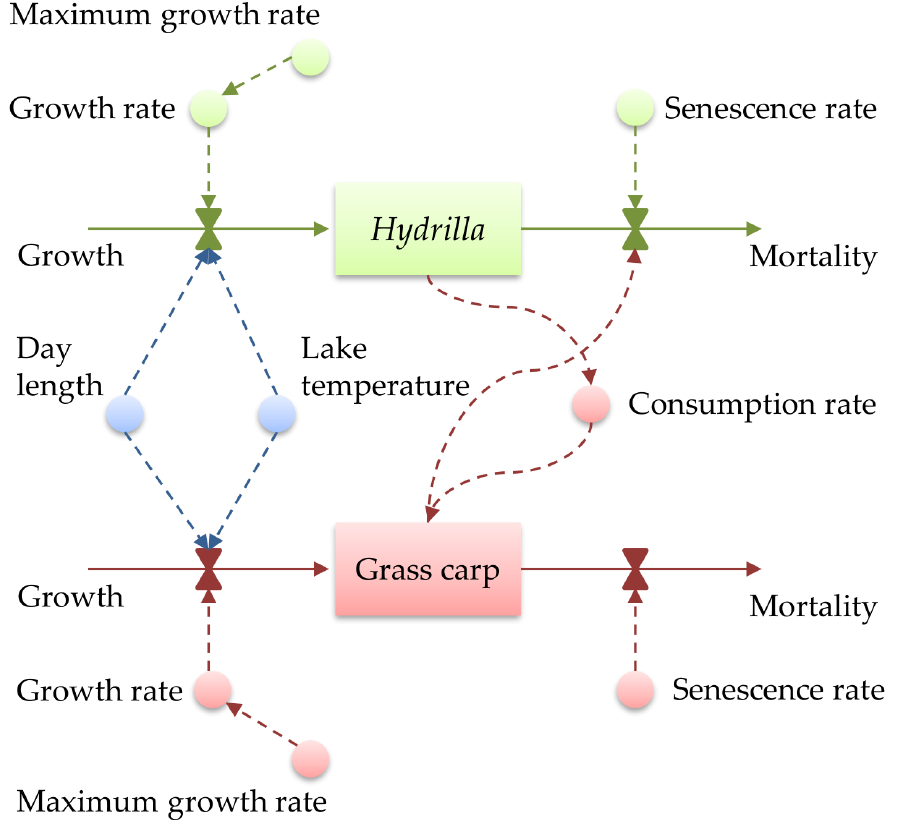
Figure 1. Conceptual model representing the growth and senescence of Hydrilla , the growth, and mortality of grass carp, and the consumption of Hydrilla by grass carp.